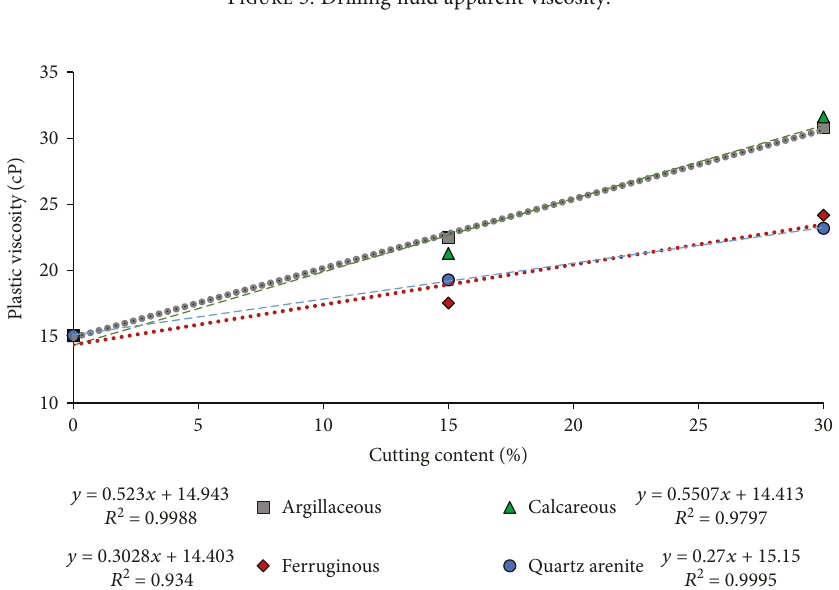
Figure 5: Drilling fl uid apparent viscosity.